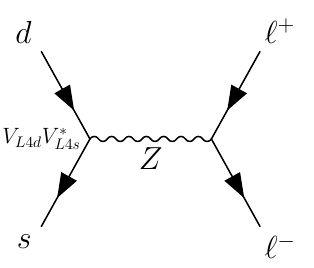
Figure 7 . Tree level contribution to the rare kaon decays K 0 → π 0 ‘ + ‘ − , K 0 → µ + µ − ( ‘ = e, µ ) arising from the mixing of the SM families with the extra downtype vector-like